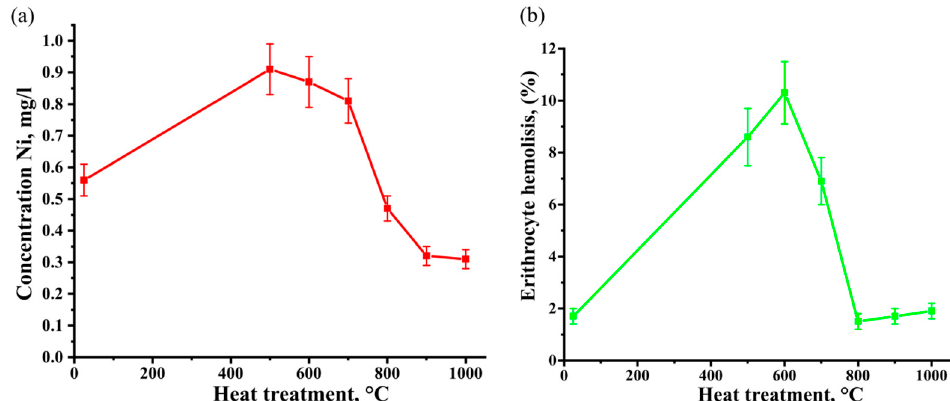
Figure 6. ( a ) The concentration of nickel accumulated in the solution is 1 macc. % HCl as a result of corrosion of porous heat treated NiTi-alloys samples for 1800 h (red line), ( b ) hemolysis percentage of porous heat treated NiTi-alloys samples (green line).